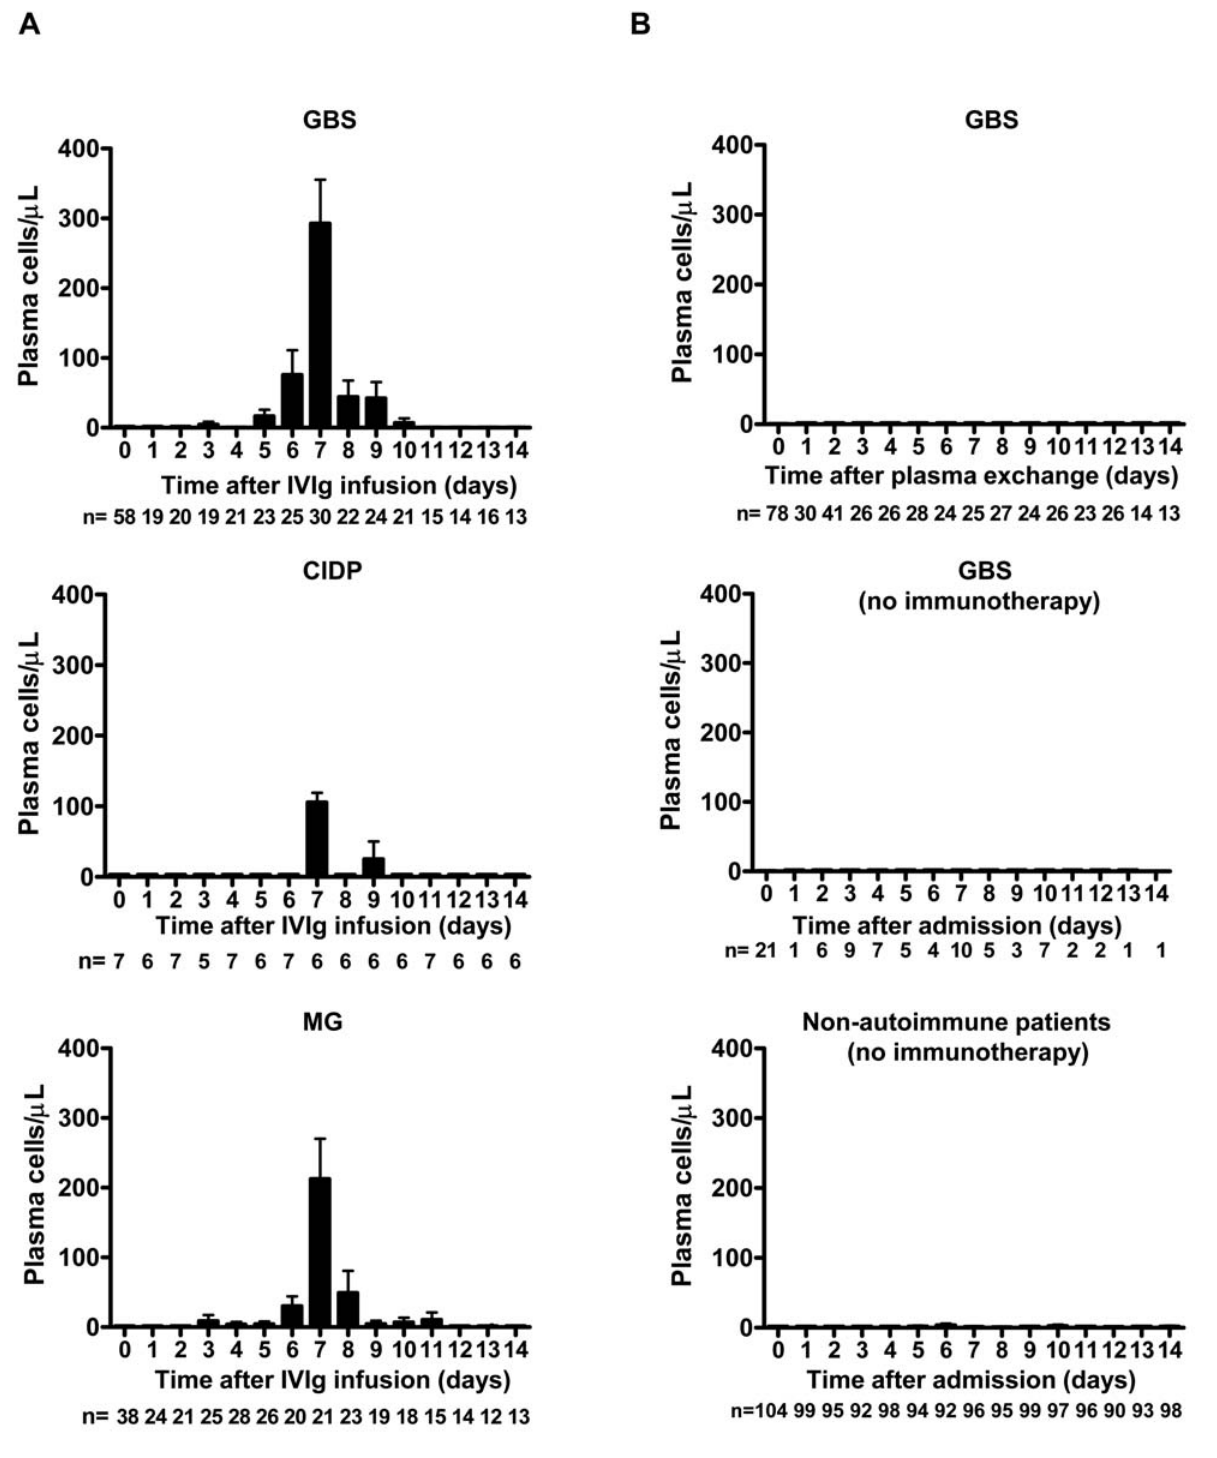
Figure 1. IVIg-related peripheral plasmacytosis peaks on day 7 of treatment in retrospective study. (A) Mean absolute number of plasma cells in IVIg-treated GBS (n=58, upper panel), CIDP (n=7, middle panel), and MG (n=38, lower panel) patients. Severely disabled GBS patients (disability grade 3 or more) received IVIg only, whereas CIDP and MG patients received IVIg and steroids at admission (day0). (B) Mean plasma cell counts in non-IVIg-treated patients over a 14-day period following admission. Severely disabled GBS patients (n=78, upper panel) were treated with plasma exchange at admission (day0). Moderately disabled GBS patients (disability grade 2 or less, n=21, middle panel) and non-autoimmune patients (n=104, lower panel) did not receive any immunotherapy during admission. At each time point, the number of patients with recorded white blood cell count is indicated. Data are mean 6 s.e.m.